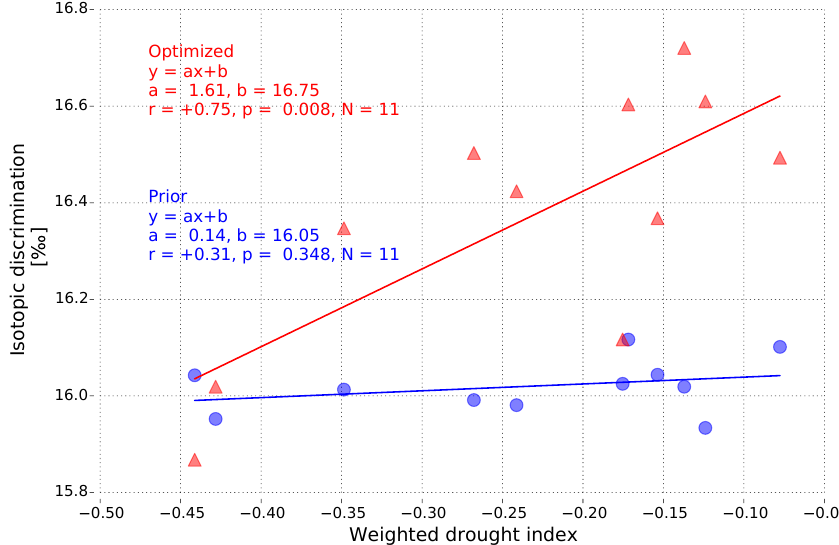
Figure 11. Weighted SPEI drought index (WDI) versus annual mean isotopic discrimination (cid:49) ph integrated over the North American temperate domain. Results from the SiBCASA biosphere model (blue circles) show no significant correlation between (cid:49) ph and large-scale droughts, while the simultaneous optimization of carbon sinks and (cid:49) ph with atmospheric CO 2 and δ 13 C observations (red triangles) suggests a highly significant correlation can be derived. The slope of the red regression line is 1.61‰/WDI ( p = 0 . 008, 95% confidence interval of a two-sided distribution with 9 degrees of freedom). The SiBCASA slope is, however, not significantly different from zero ( p (cid:29) 0 . 05). The integrated (cid:49) ph values are GPP-weighted per grid box as in Fig. 10. WDI is based on the SPEI index but area weighted to give years with large serried areas that experienced severe droughts (with SPEI smaller than − 1.2) more